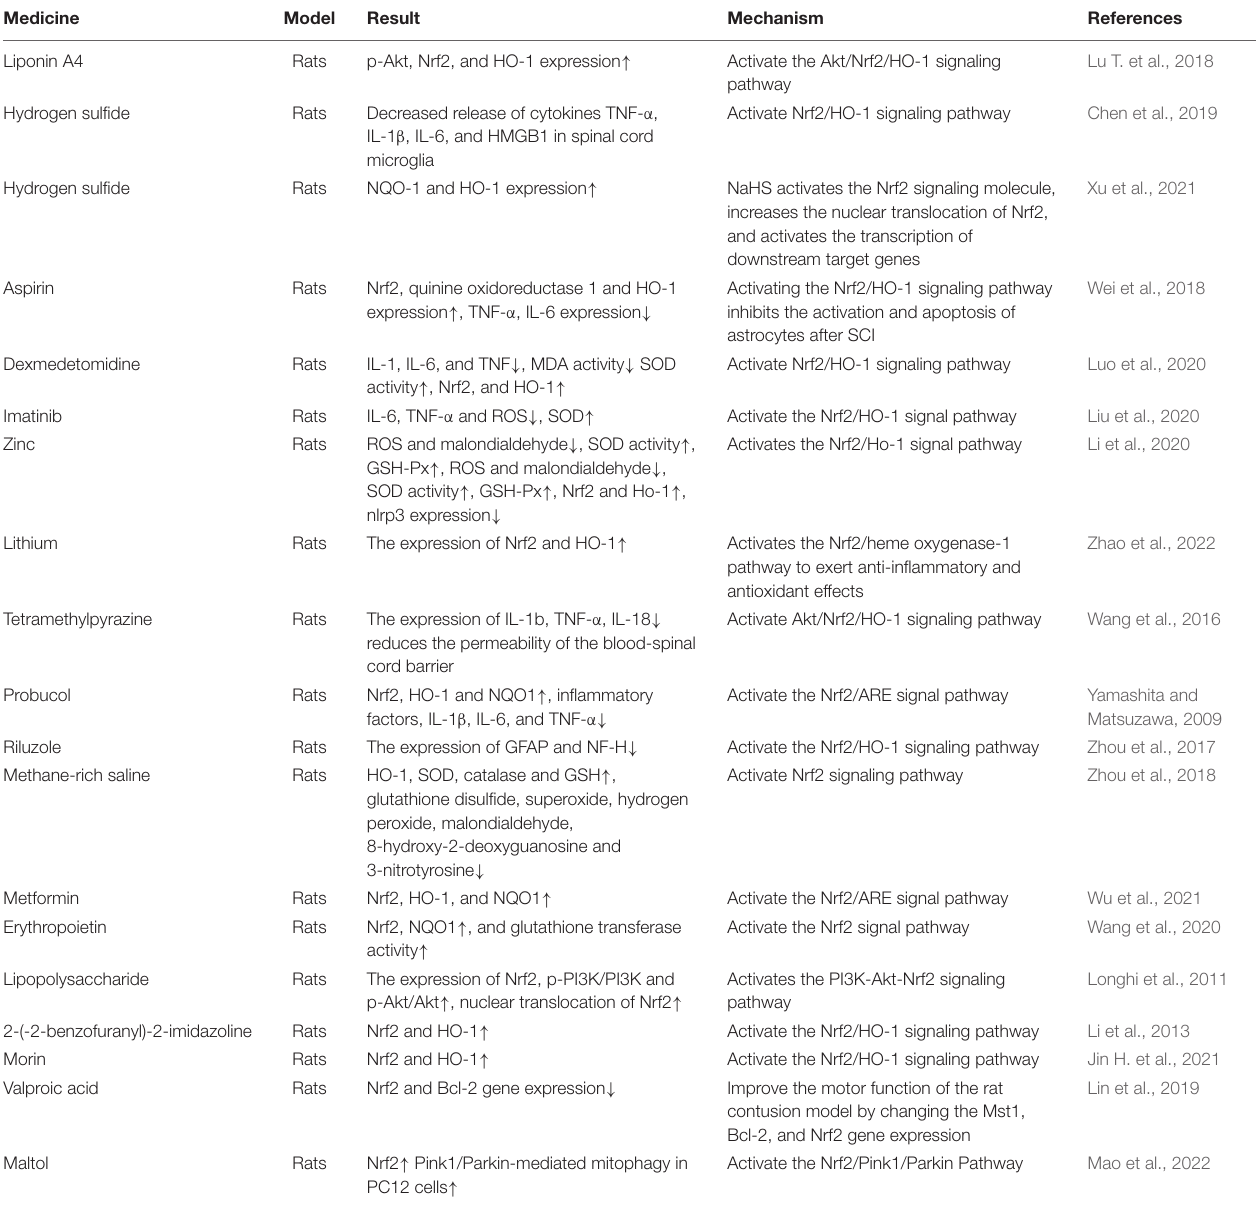
TABLE 2 | The therapeutic effect of western medicine on spinal cord